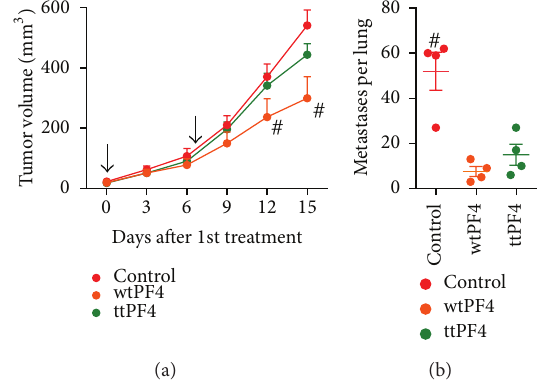
Figure 4: Tumor-targeting PF4 gene therapy with the VNTANST sequence does not improve anticancer efficacy. Black arrows repre- sent treatments. # represents 𝑃 < 0.05 compared to all other groups. (a) Only wtPF4 was capable of inhibiting primary tumor growth, but both wtPF4 and ttPF4 equally inhibited the development of lung metastases (b). Black arrows represent treatments. # represents 𝑃 < 0.05 compared to all other